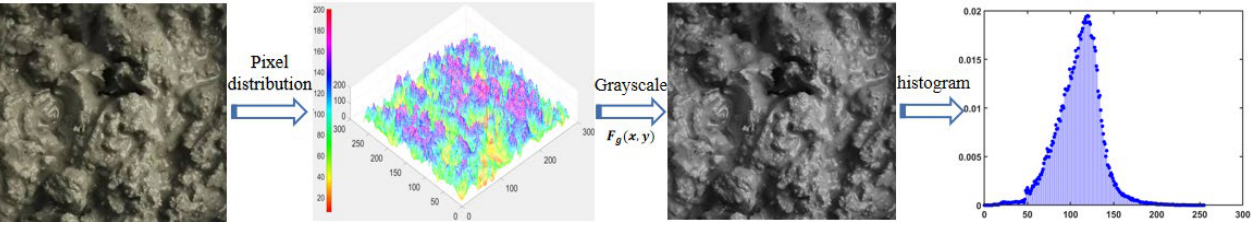
Figure 5. Image grayscale.